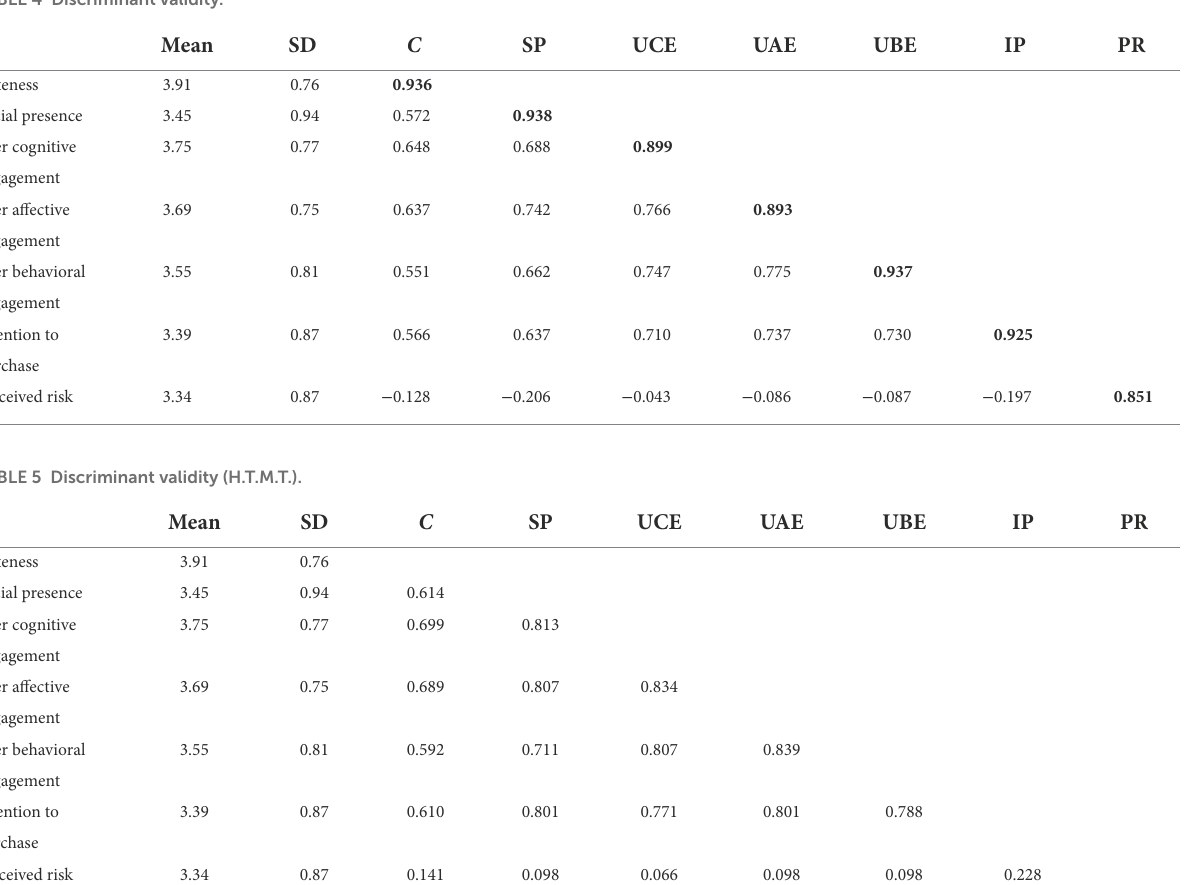
TABLE 4 Discriminant validity.